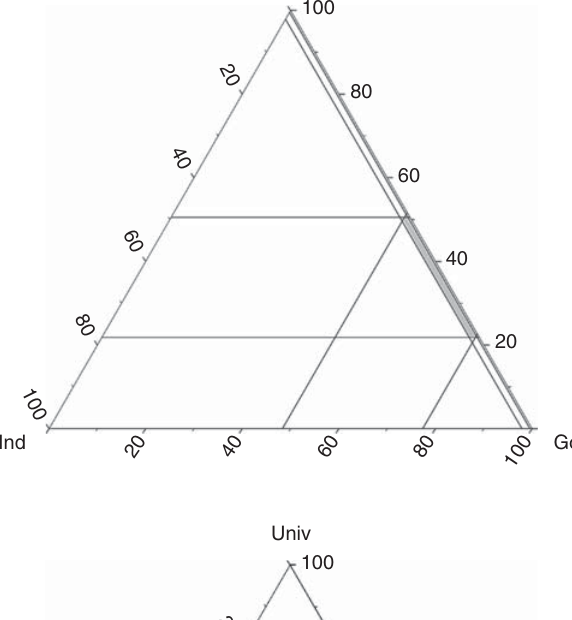
Figure 6. Core of Senegal